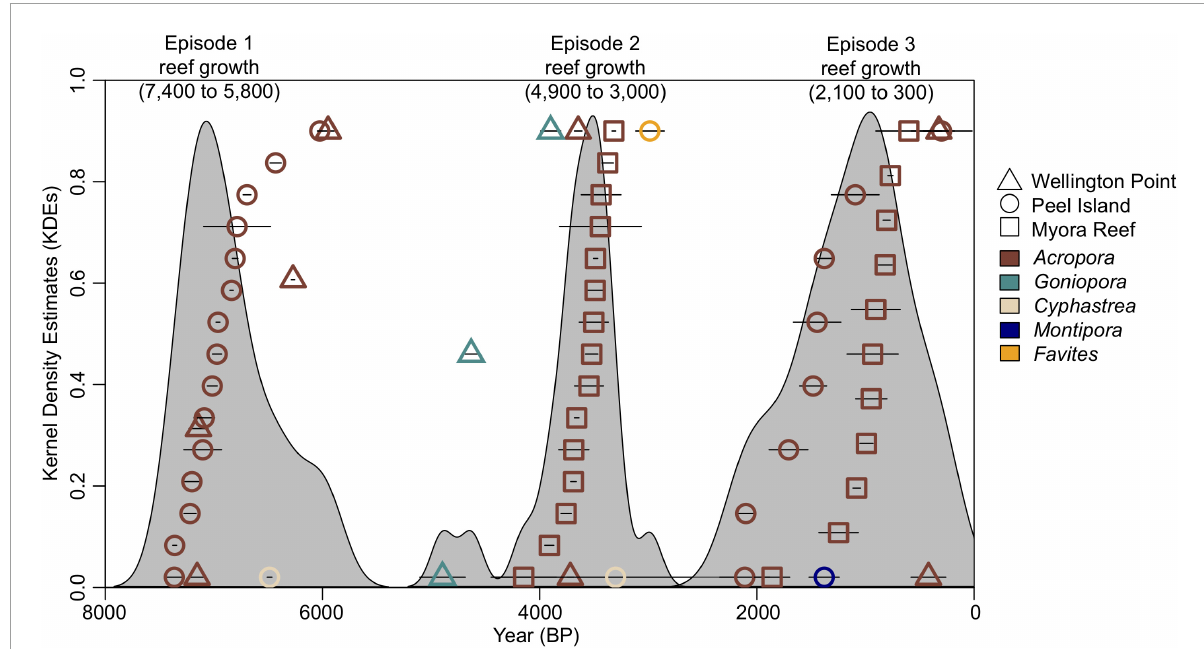
FIGURE2 Relative probability plots of radiometric (U-Th) age-dates for Moreton Bay, derived from reef sediment cores showing episodes of reef growth: Episode 1 (7,400 to 5,800 years BP), Episode 2 (4,900 to 3,000 years BP), and Episode 3 (2,100 to 300 years BP). Error bars are ± 2SD per date. Gray shaded regions represent Kernel Density Estimates (KDEs).